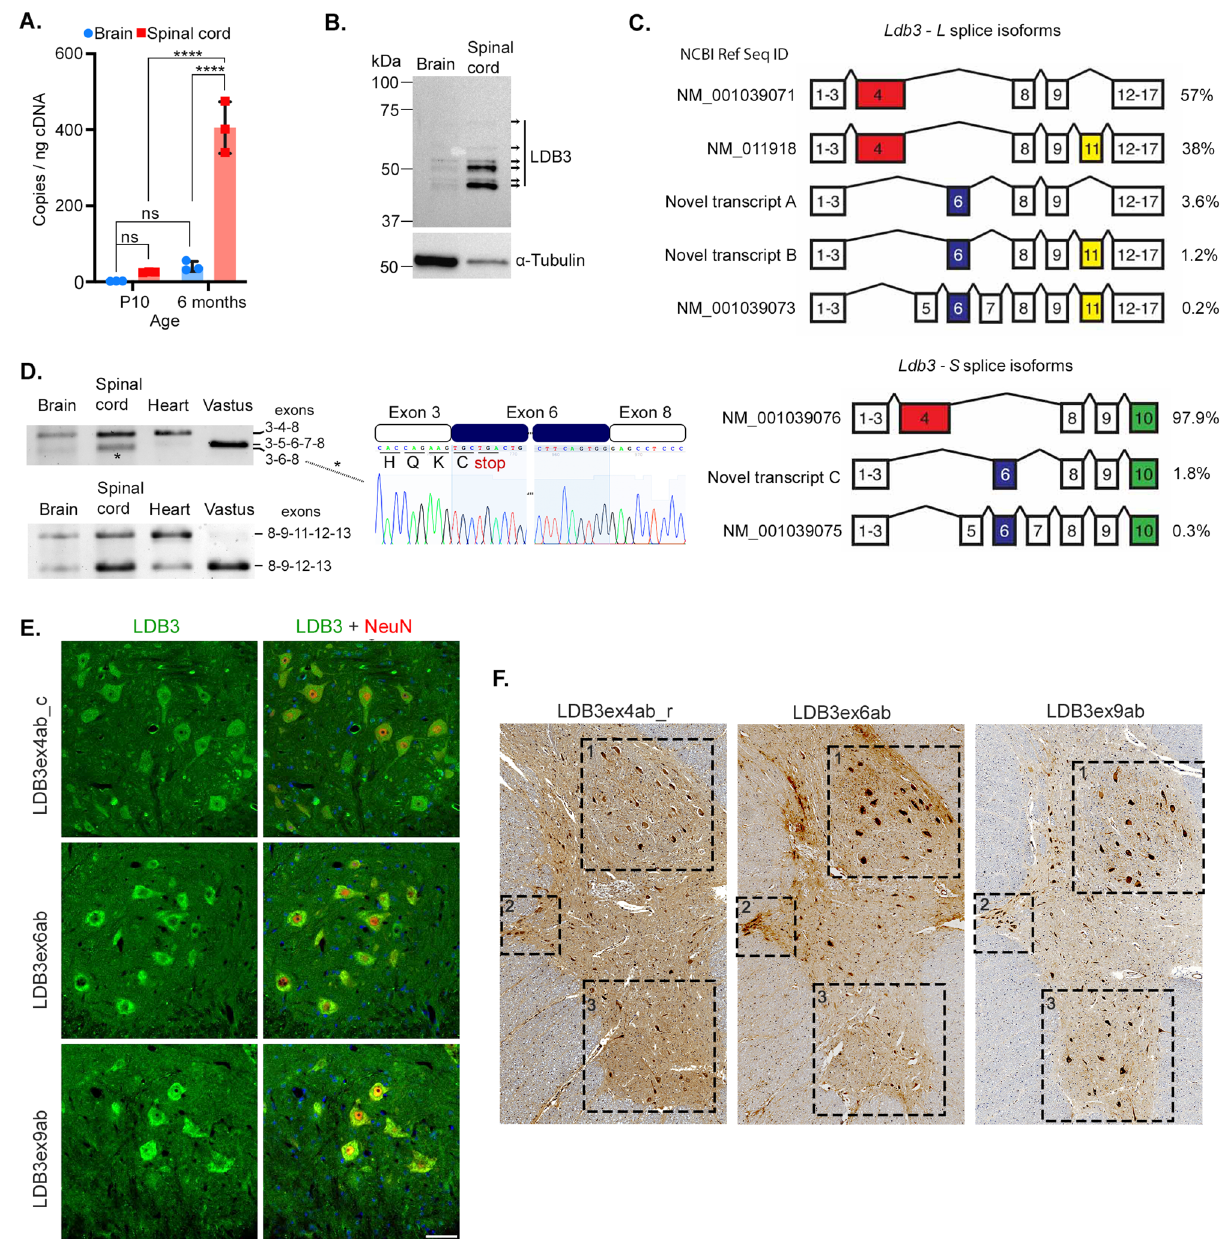
Figure 1. Expression of LDB3 splice isoforms in brain and spinal cord. ( A ) Expression levels of Ldb3 mRNA in brain (blue circle) and spinal cord (red square) of 10-day (P10)- and 6 month-old mice measured with ddPCR assays using equal amounts of input cDNA per reaction. The bar graph with scatter plot represents mean ± S.D.; n = 3 mice; triplicate assay; a two-way ANOVA with the Bonferroni correction ****p < 0.0001. ( B ) A representative immunoblot of LDB3 isoforms in human motor cortex and spinal cord detected by a rabbit monoclonal antibody (Abcam; ab171936). Multiple bands are seen between 37 and 75 kDa (arrows). Two-fold higher amount of proteins was loaded from the brain lysate compared to the spinal cord; α-tubulin served as a loading control. ( C ) Spectrum of LDB3-L and LDB3-S isoforms detected by SMRT sequencing in the brain of six month old mice (n = 3). Relative percentages of total reads are shown. ( D ) Representative gel electrophoresis of Ldb3 splice isoforms in different mouse tissues in a RT-PCR assay (n = 6 mice). Exon composition identified by Sanger sequencing is indicated. Chromatogram of a cloned amplicon from the lower band (*) in the spinal cord validates the novel splicing events joining Ldb3 exon 3 to 6 and exon 6 to 8. Predicted reading frame including premature stop codon in exon 6 is shown. Dotted line indicates continuity of exon 6 sequence in the chromatogram. See Supplementary Table S2 for all primer sequences. ( E ) Representative immunofluorescence on lumbar spinal cord cross sections of six month old mice (n = 6) show staining for the exon domain-specific LDB3 antibodies (green) in NeuN (red)-positive neurons of the anterior horn. Scale bar: 20 µm. ( F ) Representative immunohistochemistry on serial cross sections of human L1-L2 spinal segments (n = 3 autopsies) show staining for the exon-specific antibodies in neurons of Clarke’s dorsal nucleus (1), the lateral column (2), and the anterior horn (3). Individual tiles were acquired at 20 × magnification and stitched together into a composite image. Original blots/gels for the image B and D are presented in Supplementary Fig. 2 of supplementary file